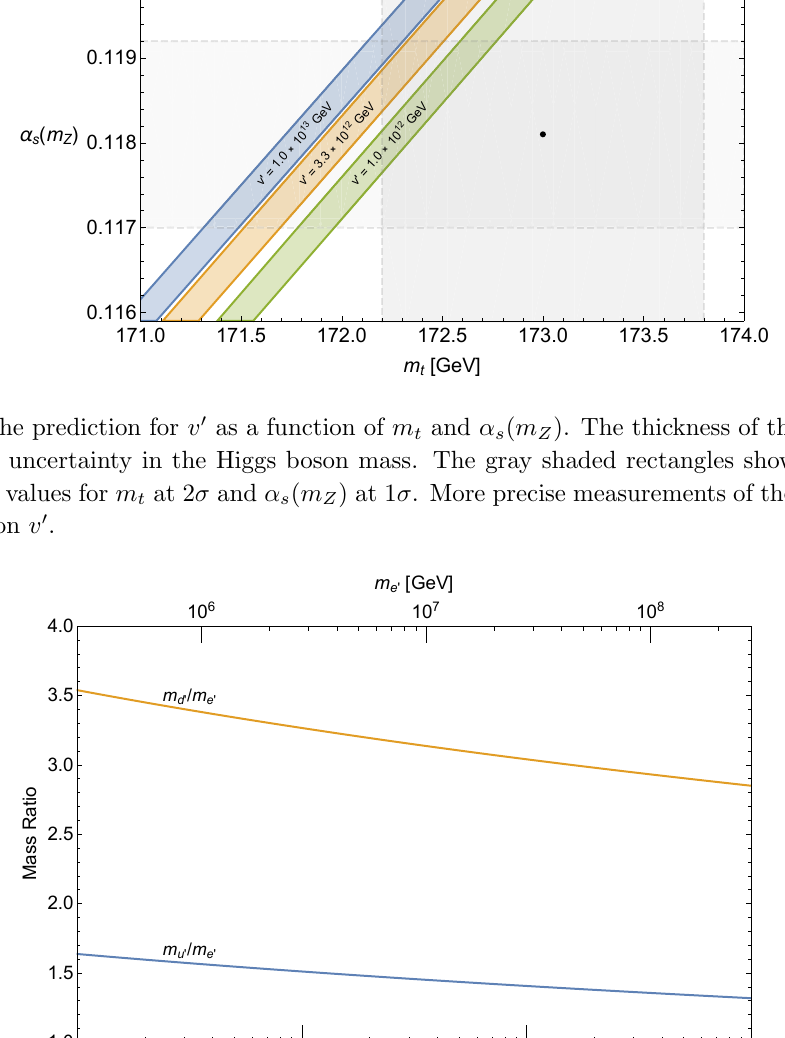
and d (cid:31) , u (cid:31) (cid:31)